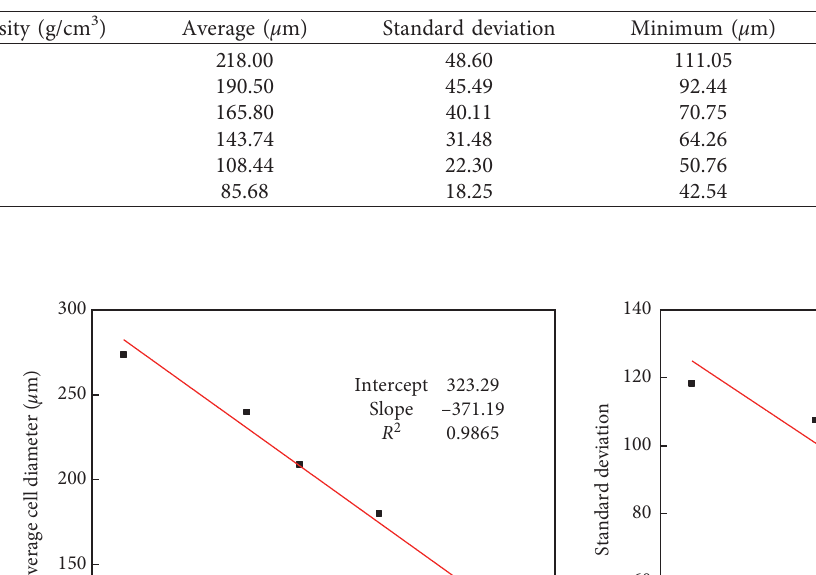
Table 3: Summary of the statistical parameters of the section cell diameter